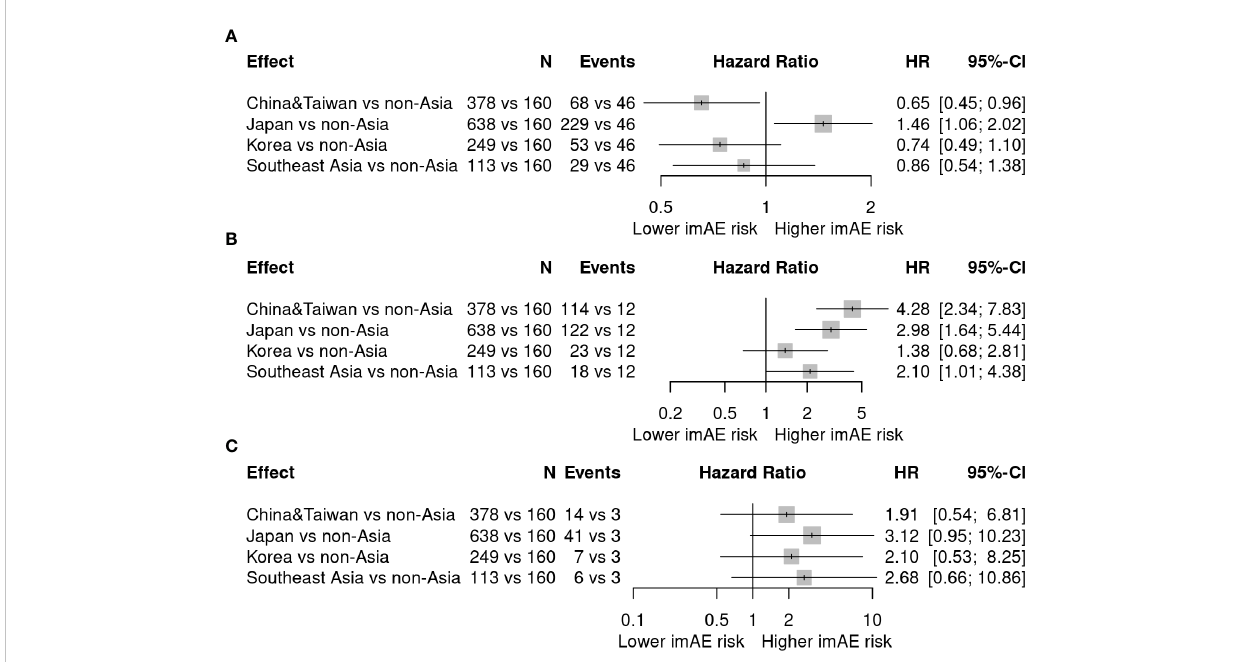
FIGURE 3 Forest Plots of the country effect in patients with Asian ancestry (hazard ratio [HR] estimates and 95%-con fi dence intervals [CI]) adjusted for important confounders: age, BMI, sex and treatment. Each Asian country is compared against the group of all non-Asian countries (reference group). The effect estimates are obtained by combining data from all Asian patients across all studies in an individual patient data meta-analysis including country and the confounding factors as fi xed effects and indication as a random effect. The sample size (N) and number of irAEs (Events) are given